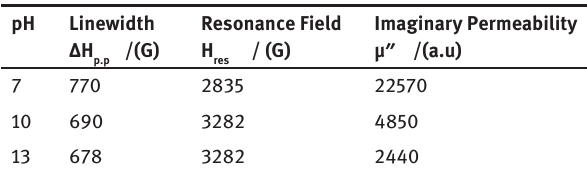
Table 4: FMR parameters for pH values: 7, 10 and 13 at frequency of 9.7GHz.